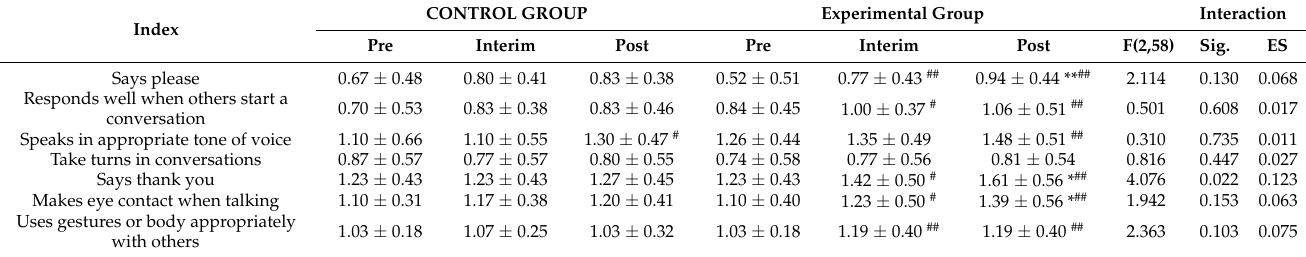
Table 8. Multivariate analysis on the seven items of communication for two groups.